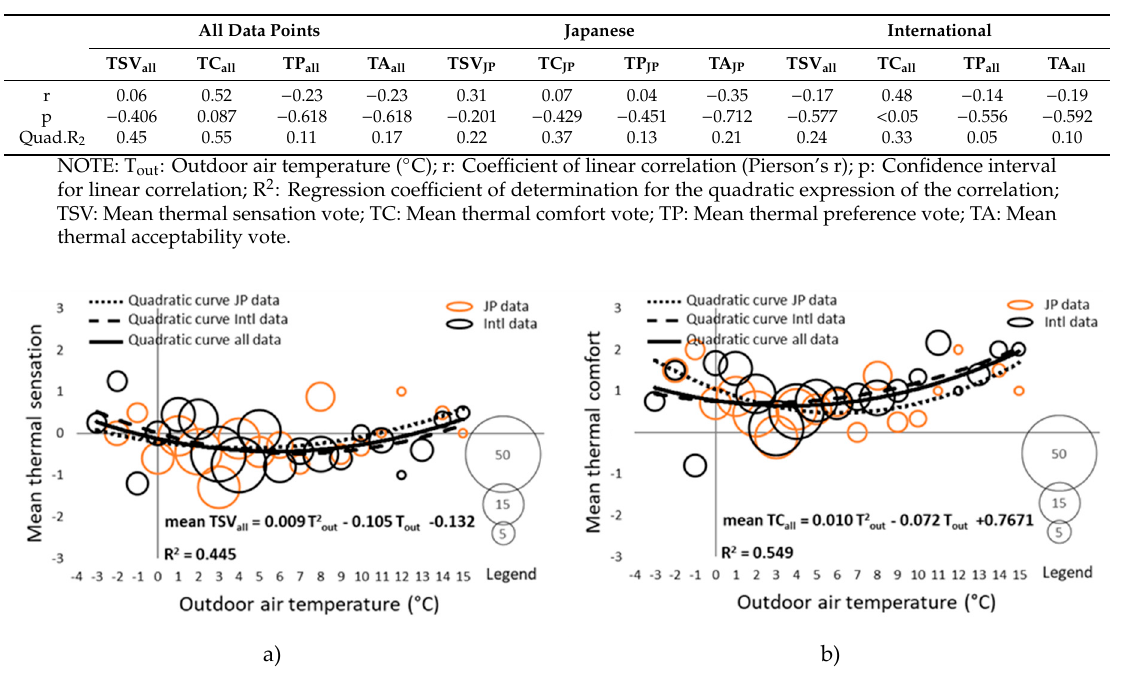
Table 6. Correlation between thermal responses.